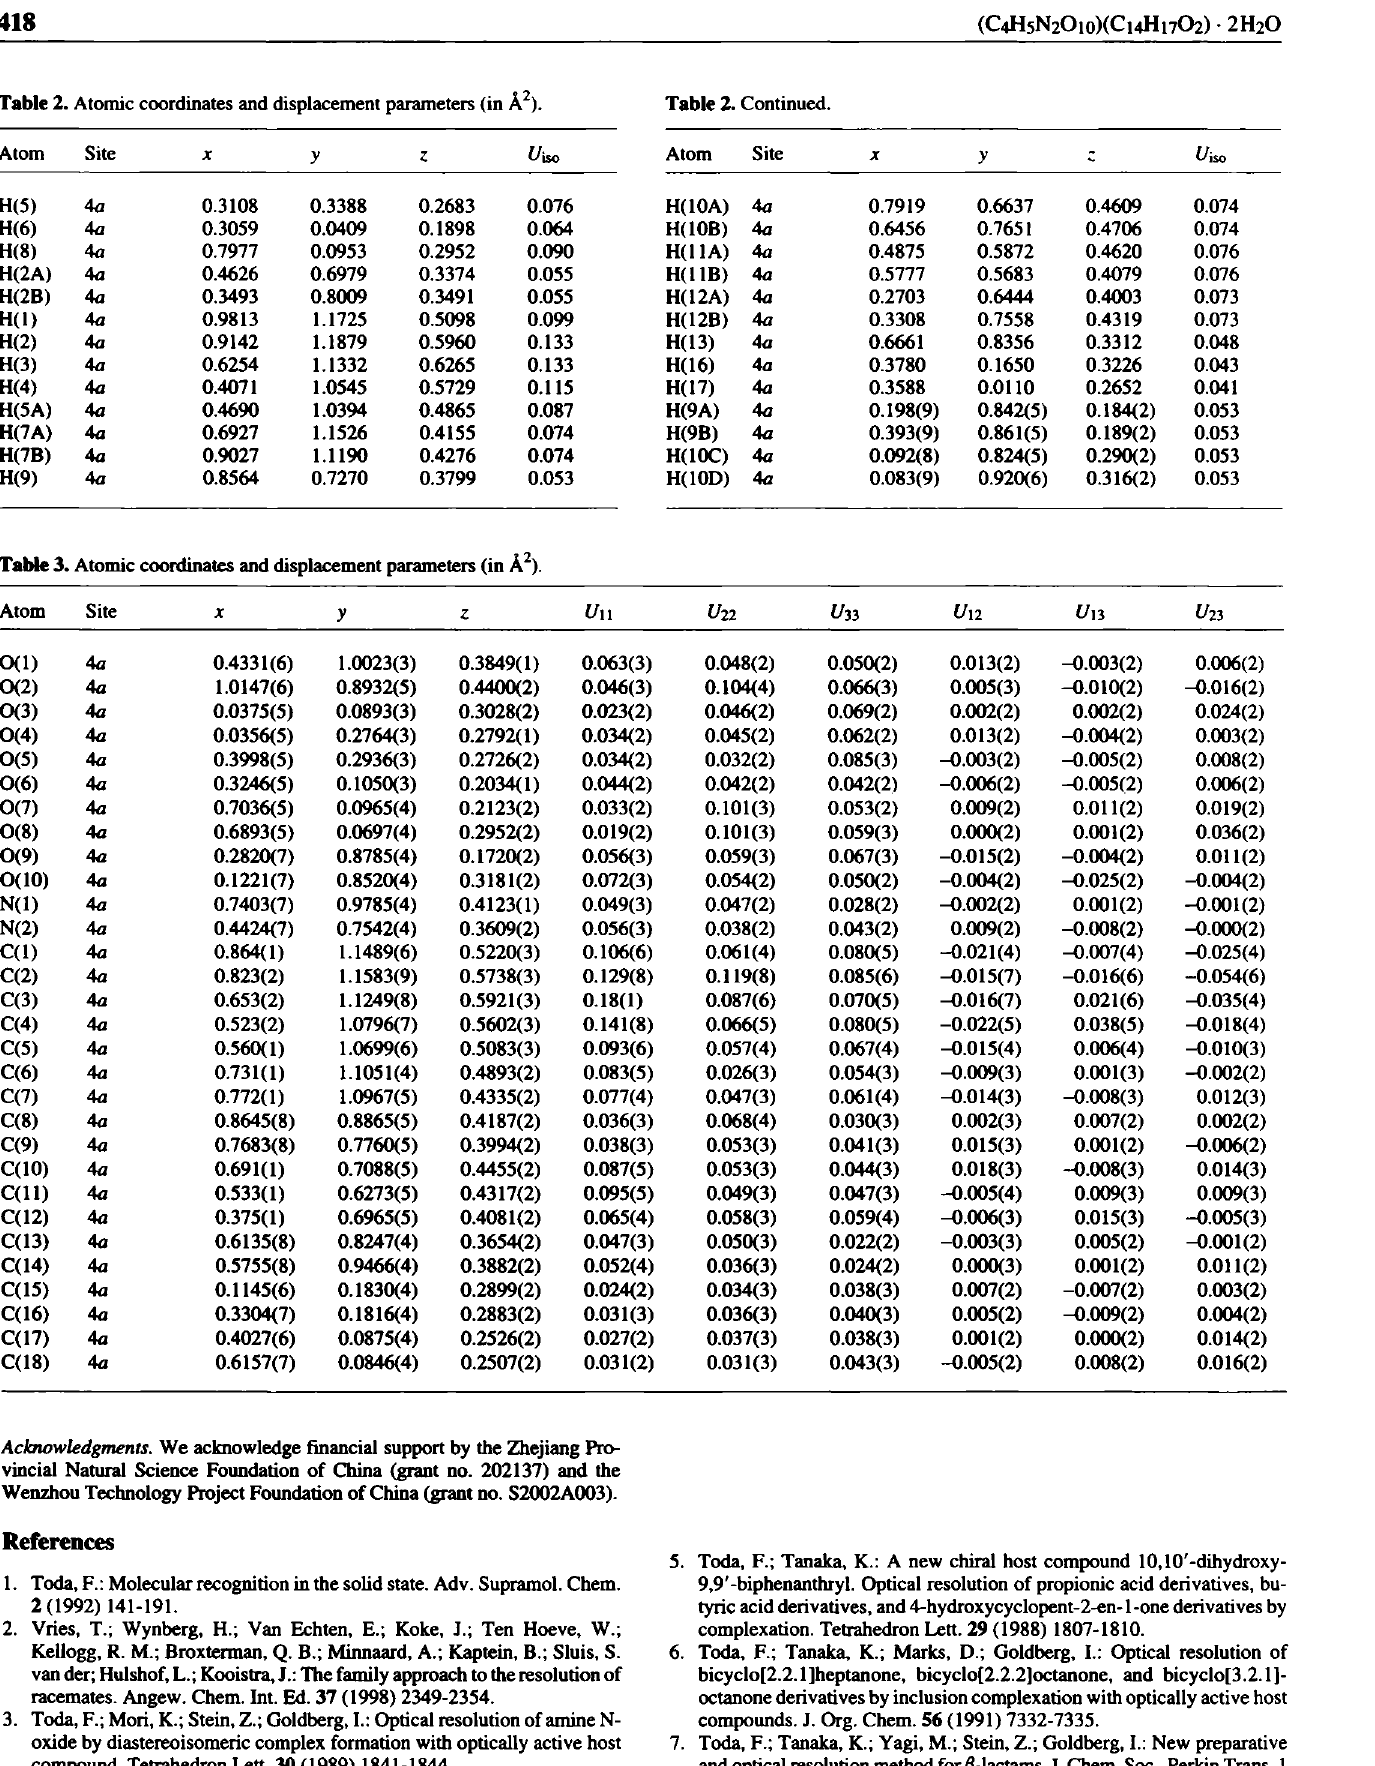
Table 3. Atomic coordinates and displacement parameters (in A 2